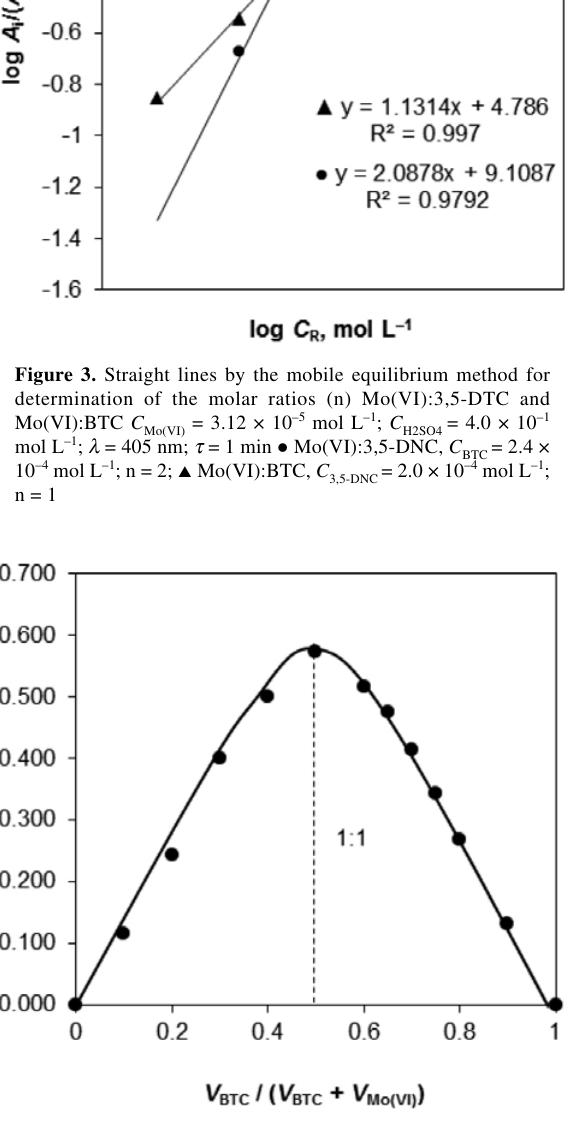
Figure 4. Determination of the molar ratio (n) Mo(VI):BTC by the method of continuous variations C L –1 ; C = 2.0 × 10 –4 mol L –1 ; C 3,5-DNC 405 nm; τ = 1 min